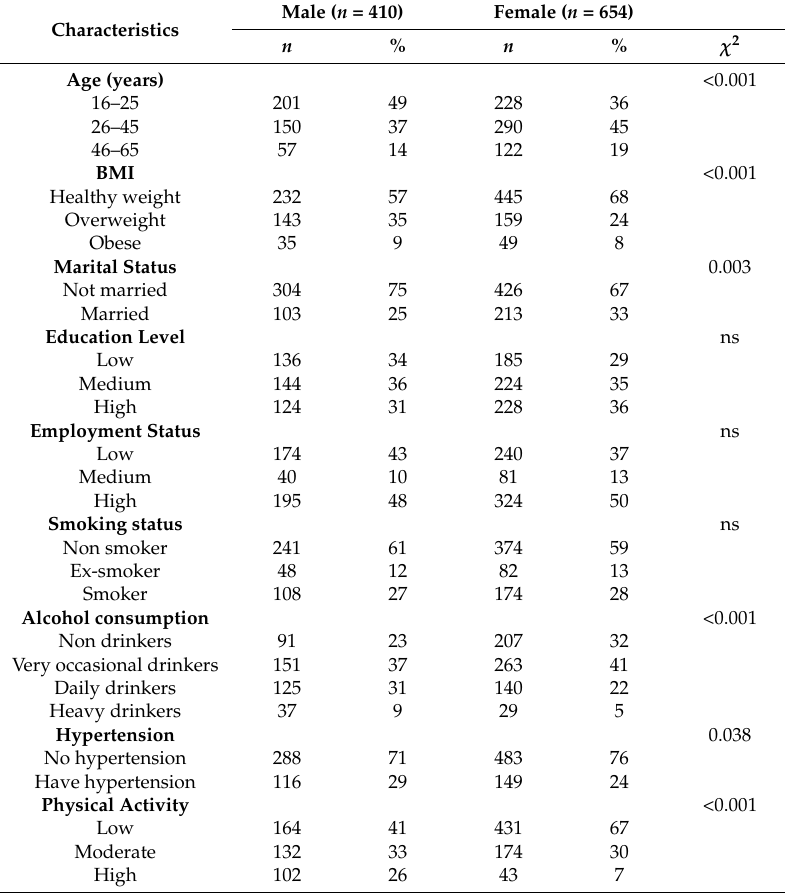
Table 1. Socio-demographic and lifestyle characteristics of study